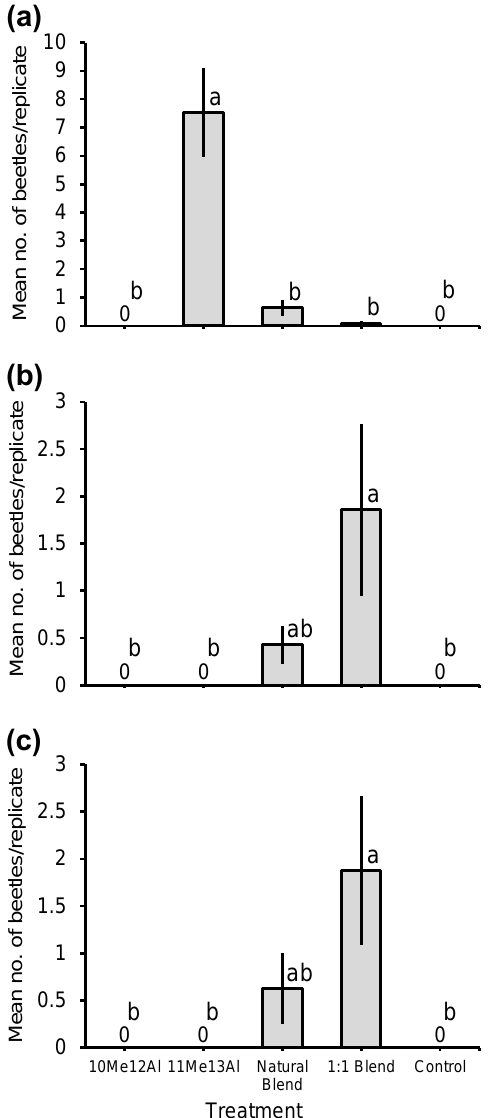
Figure 6. Mean ( ± 1 SE) numbers of adult males and females of ( a ) Eburodacrys dubitata , ( b ) Eburodacrys flexuosa and ( c ) Eburodacrys lenkoi caught during bioassays testing the synthetic pheromone candidates for Eburodacrys assimilis in Anhembi in 2018. Treatments: 10Me12Al = racemic 10-methyldodecanal; 11Me13Al = racemic 11-methyltridecanal; Natural blend = 36:100 blend of racemic 10-methyldodecanal and 11-methyltridecanal (ratio produced by adult males of E. assimilis ); 1:1 Blend = 1:1 blend of the two aldehydes; and Control = neat isopropanol. Means related to the same species capped by different letters are significantly different (REGWQ multiple range test: p ≤ 0.05).